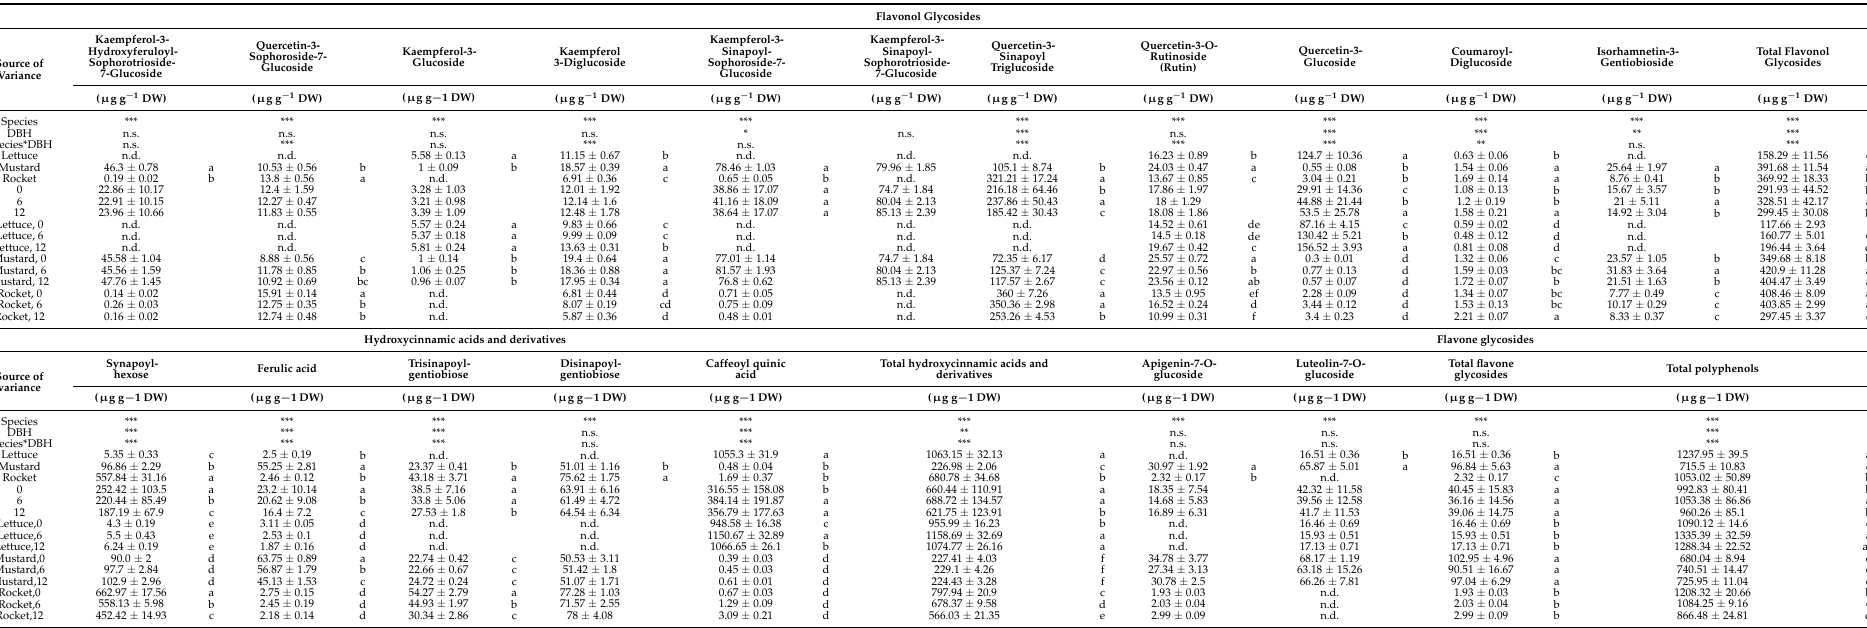
Table 5. Phenolic composition of three microgreen species (lettuce, mustard, and rocket) in response to nutrient deprivation treatment (DBH) applied for 6 or 12 days before harvest. All data are expressed as mean ± standard error, n =